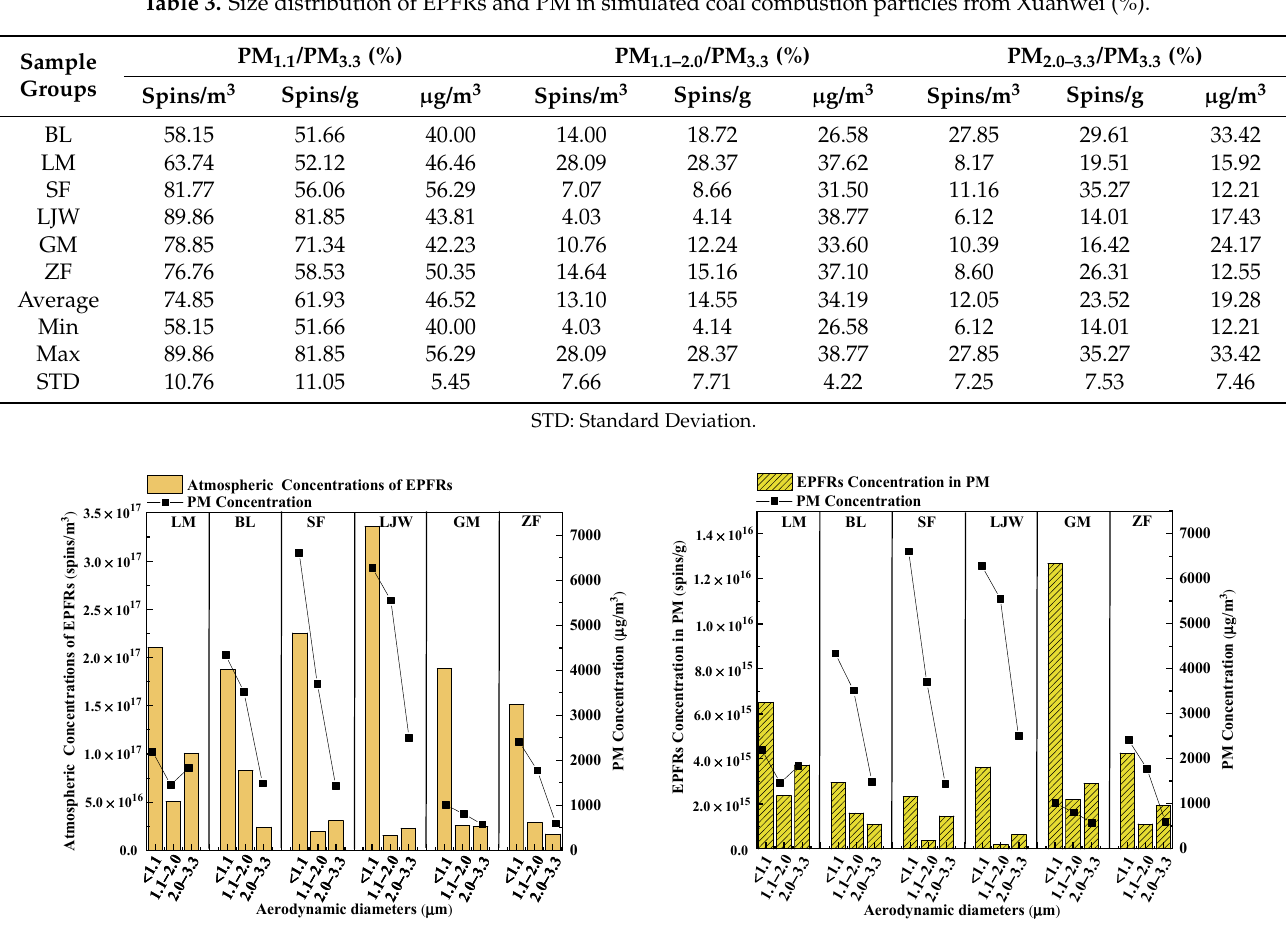
Figure 2. EPFRs and PM concentrations in coal combustion particles from Xuanwei (the left : the atmospheric EPFRs concentrations; the right : EPFRs concentrations in PM).